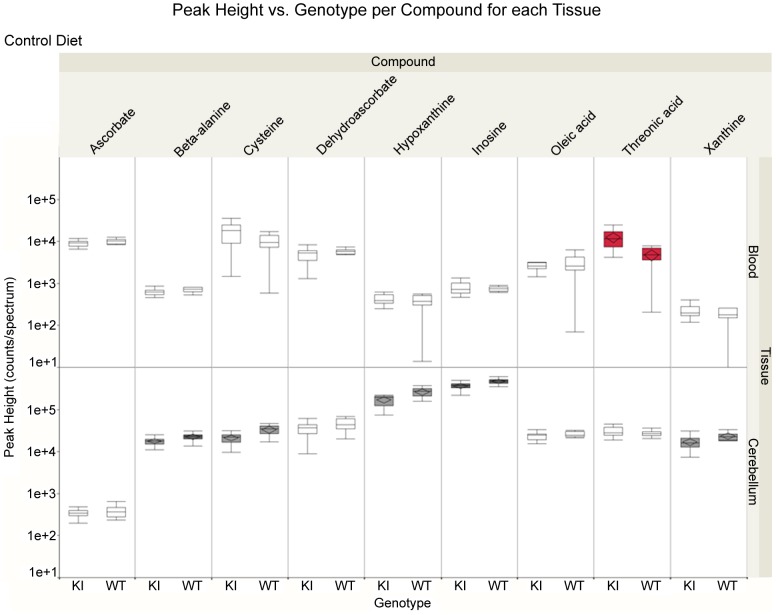
Effect of introducing the Sca1154Q/+ gene into the wild-type genetic background for plasma and cerebellum.Individual box-whisker plots for selected significantly regulated metabolites. The whiskers encompass 1.5 of the interquartile range (IQR). Median value is indicated with a line in the box. The confidence diamonds indicate average values when the two samples are statistically different (colored boxplots, red for blood and grey for brain). Abbreviations: KI, SCA1 knock-in; WT, Wild-type.